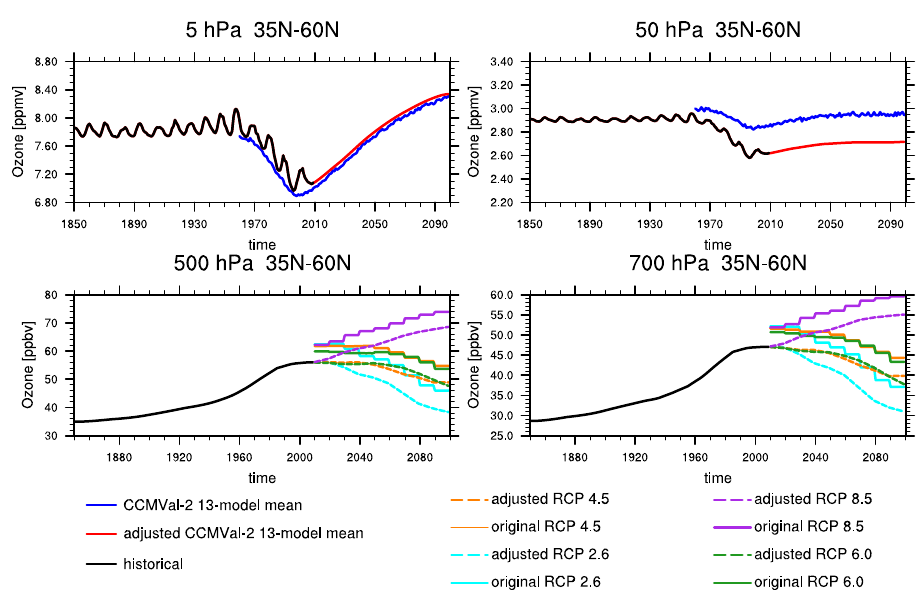
Fig. 2. Upper row: time series of annual mean northern midlatitude ozone [ppmv] at 5hPa (left) and 50hPa (right) from the historical ozone database (black line, derived from observations), the future stratospheric time series under the SRES A1B GHG scenario (blue line, derived from CCMVal-2 13-model mean), and the merged dataset (red line). Lower row: time series of annual mean northern midlatitude ozone [ppbv] at 500hPa (left) and 700hPa (right) from the historical ozone database (black line, derived from PUCCINI and CAM3.5 model mean, the future tropospheric ozone projections for the four RCPs (colored solid lines, CAM3.5 simulation), and the merged dataset (colored dashed lines).